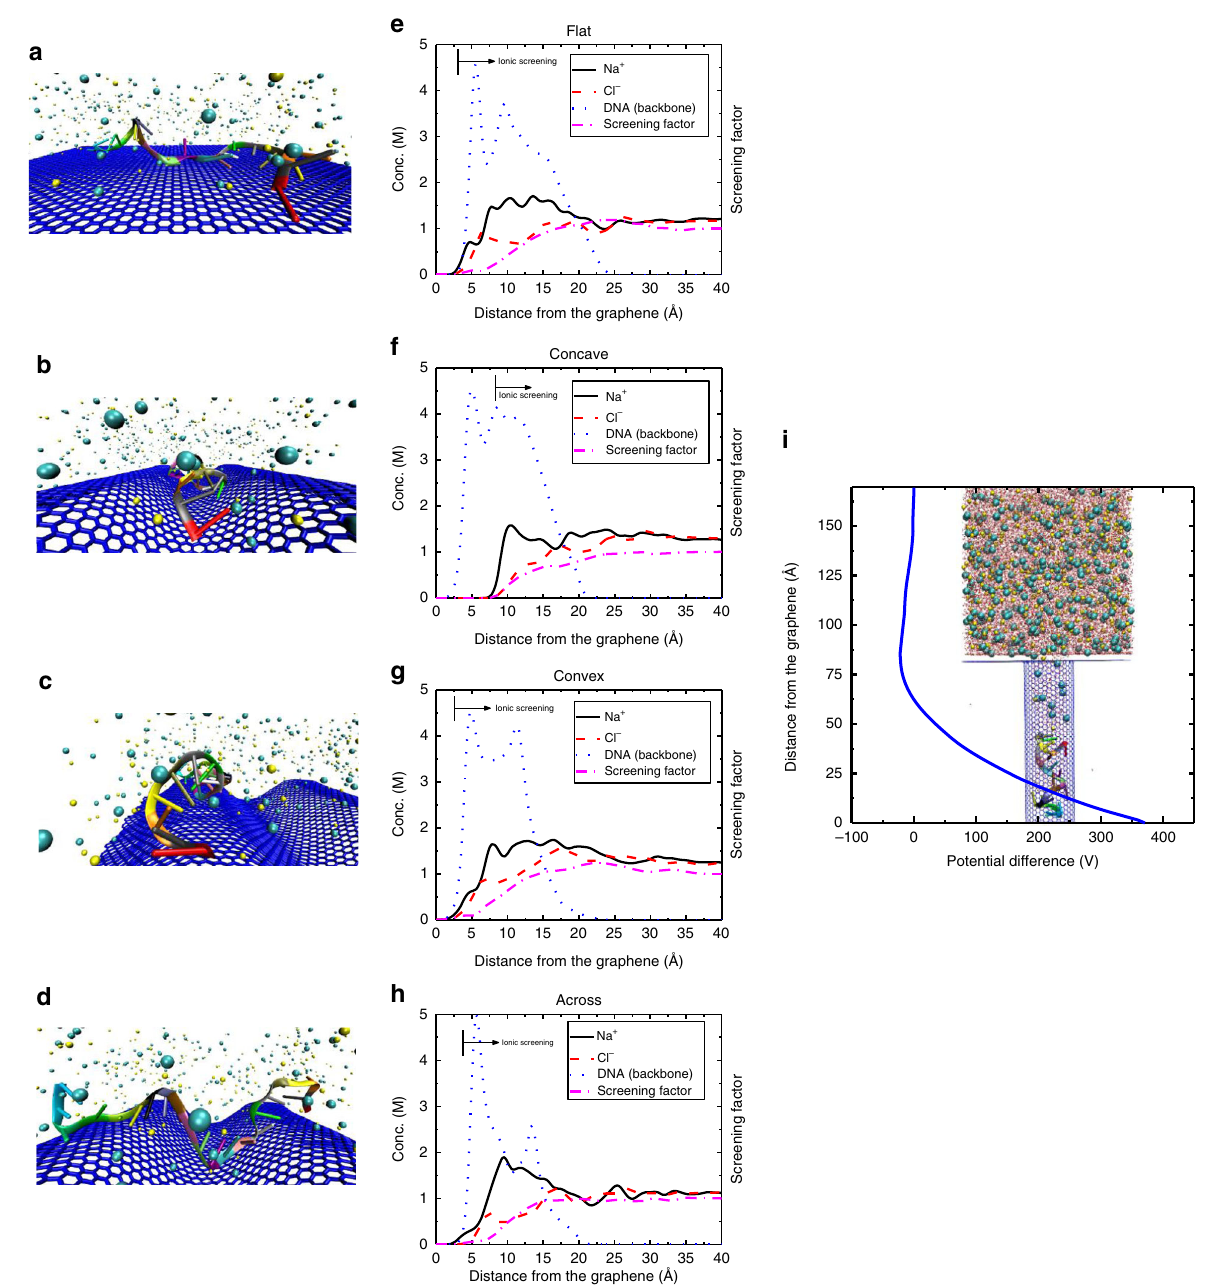
Fig. 3 The schematic of the simulations for equilibrated DNA on. a Flat graphene, b concave surface of crumpled graphene, c convex surface of crumpled graphene, and d across the graphene crumples. Graphene is shown in blue, ions are presented as cyan and yellow spheres and the DNA bases are shown in different colors. Water molecules are not shown for better presentation. The molar concentration of ions (sodium and chloride) and the backbone of DNA strand along with the screening factor of ions are plotted as a function of the distance from the graphene surface for e fl at, f concave, g convex, and h across con fi gurations of DNA. The location where the ionic screening starts to take place is shown using an arrow. In the concave region, ions are excluded due to its con fi nement and most of the adsorbed DNA molecule remains unscreened electrostatically. Less screening increases N unscreend induces more charge density in graphene resulting in a larger D i rac point shift. i The 2.45-nm diameter CNT that is used to model a narrow trench in crumpled graphene, is shown with CNT and graphene carbon atoms in blue, ions in cyan and yellow, water molecules in red and DNA strand bases in different colors. The DNA adsorbs to the bottom of the trench and excludes ions near the surface (maximizing N unscreend potential modi fi es the carrier charge density of graphene. The potential is obtained from V ð z Þ ¼ (cid:3) the system (ions, DNA and water) in z , surface area of the bottom of the trench and vacuum dielectric constant, there is almost no signi fi cant bandgap opening for the case of fl at graphene. However, when the graphene is deformed and crumpled along the armchair direction, the bandgap opens up to 1.7641 eV by adding DNA bases. Wang et al. showed that electronic mobility ( μ )